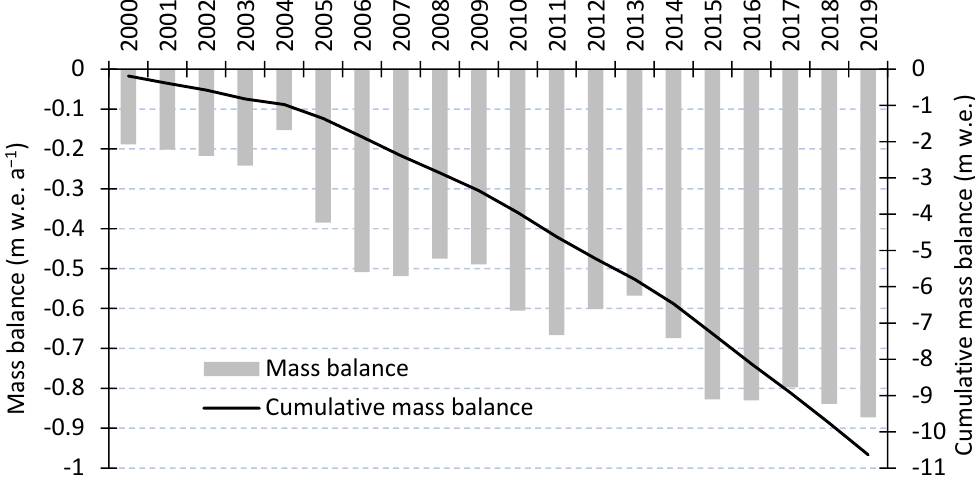
Figure 3. Mean annual geodetic mass balance (m w.e. a − 1 ) and cumulative mass balance (m w.e.) for all Caucasus glaciers in 2000–2019.